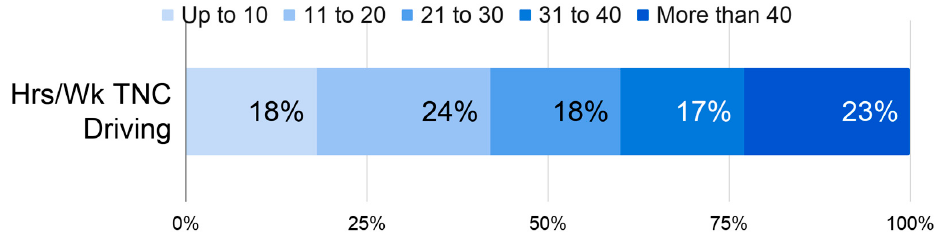
Figure 8. Average number of ride-hail driving hours per week for aggregate sample of drivers.